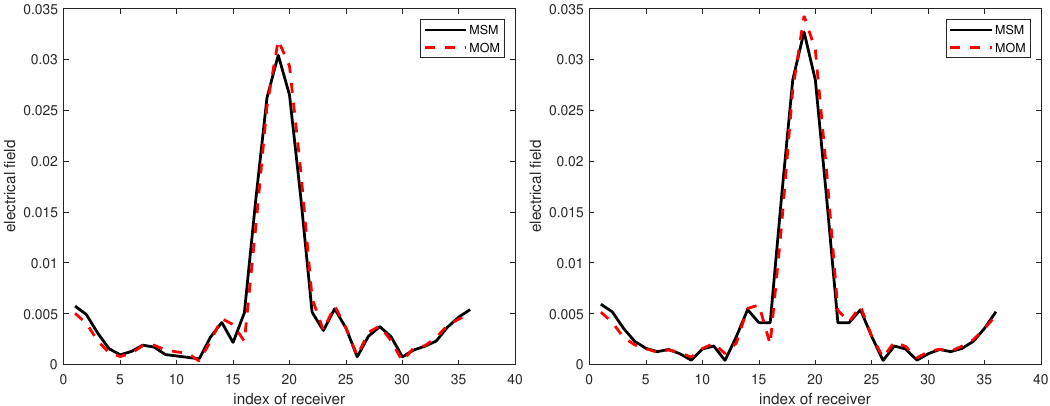
Figure 4. Comparison of the two modeling methods for a contrast of 2.5 with three missing rods ( left ), numbered 2, 12, and 30 (not shown), and no missing ones ( right ). MSM, multiple scattering